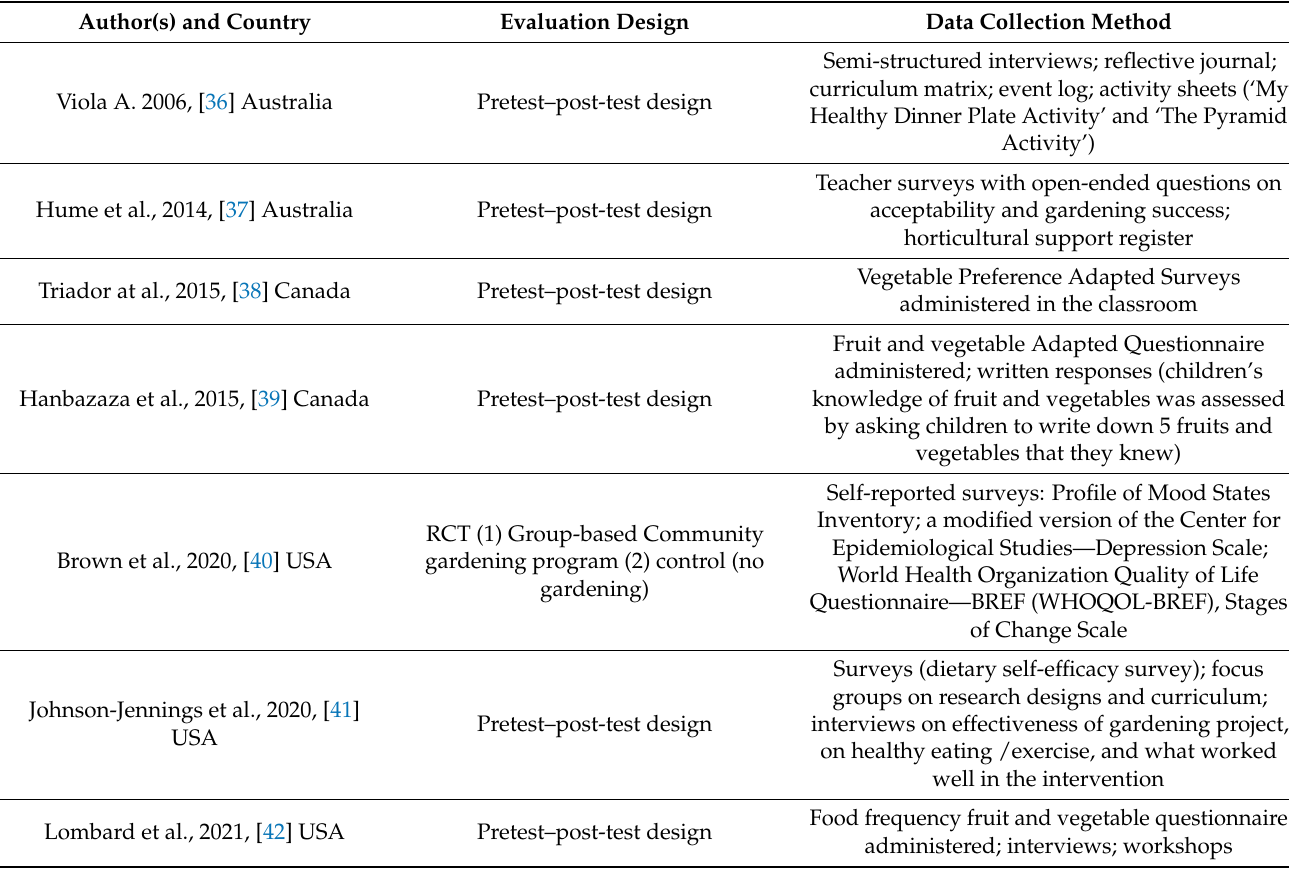
Table 2. Evaluation